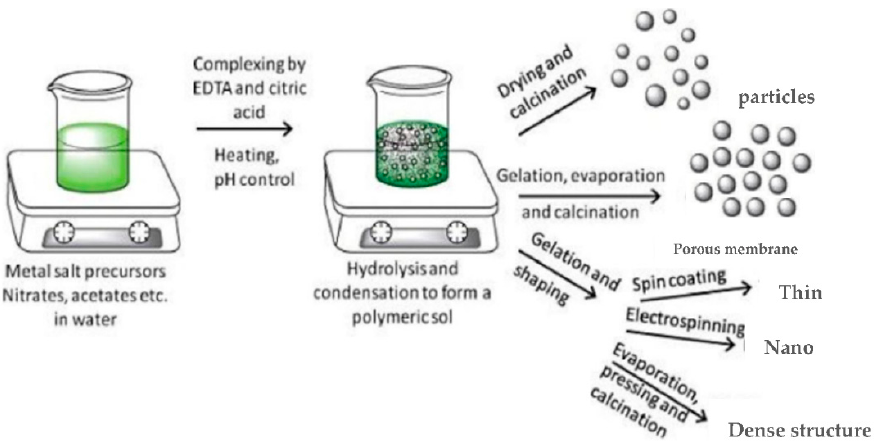
Figure 15. Steps in the sol–gel process to achieve final morphologies (Adapted from [60]).